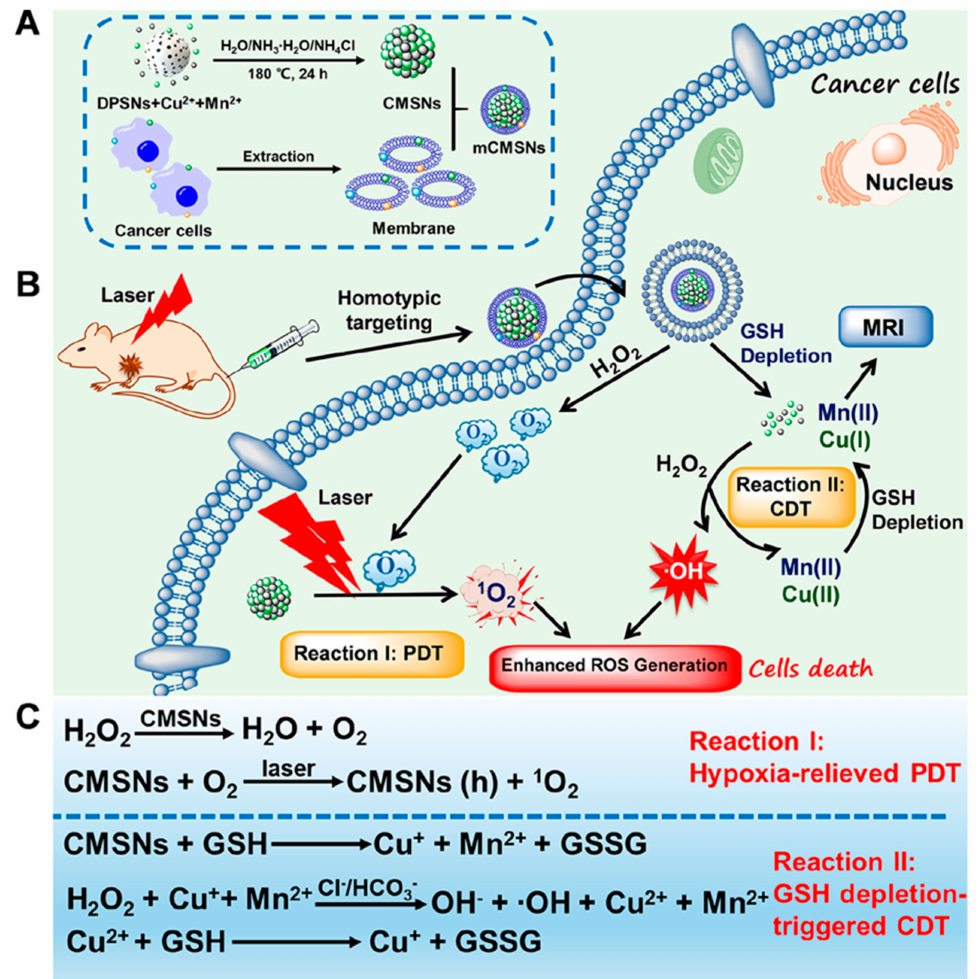
Figure 8. ( A ) Synthetic procedure of mCMSNs. ( B ) Schematic illustration of therapeutic mechanism of mCMSNs for PDT under Laser. ( C ) Chemical mechanism of GSH-triggered CDT and MRI. Adapted from